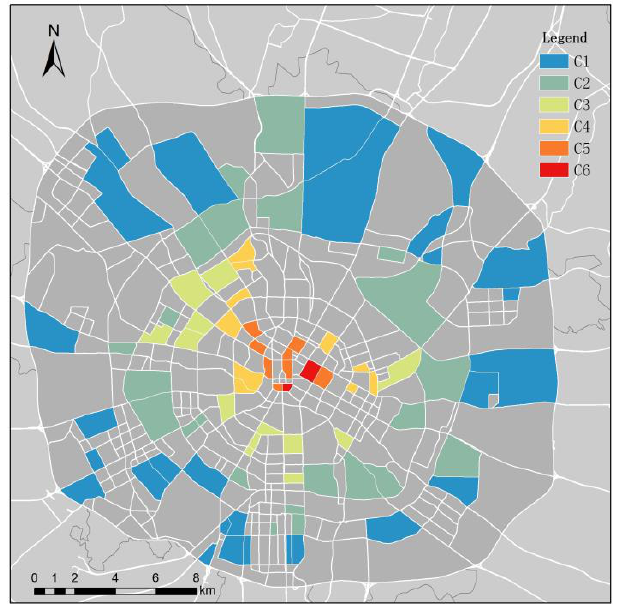
Figure 7. Selections for training samples. The baseline of the time series of each cluster was taken as the evaluation standard, and data with good clustering effects of 20% were selected as the training samples.